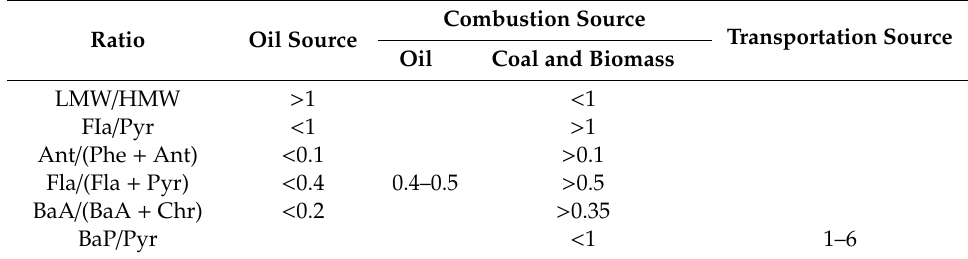
Table 2. The characteristic ratio of pollution source of